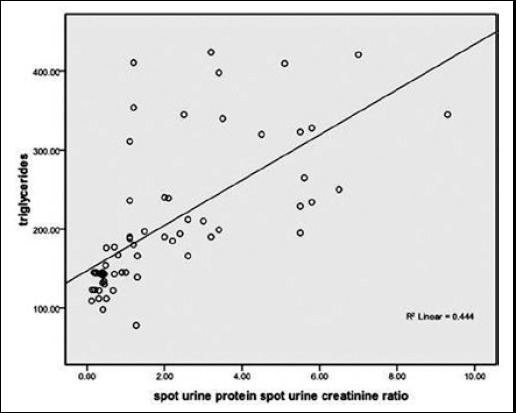
Correlation of triglycerides and Proteinuria.